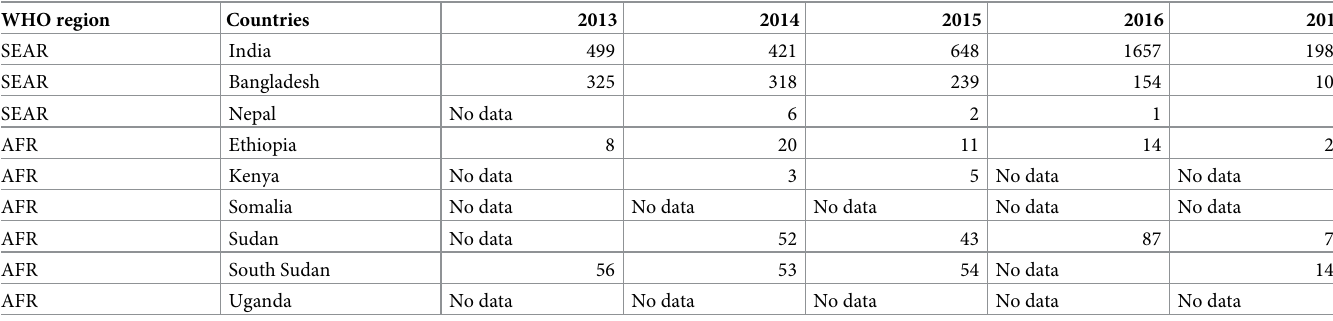
AFR: African Region; SEAR: South-East Asia